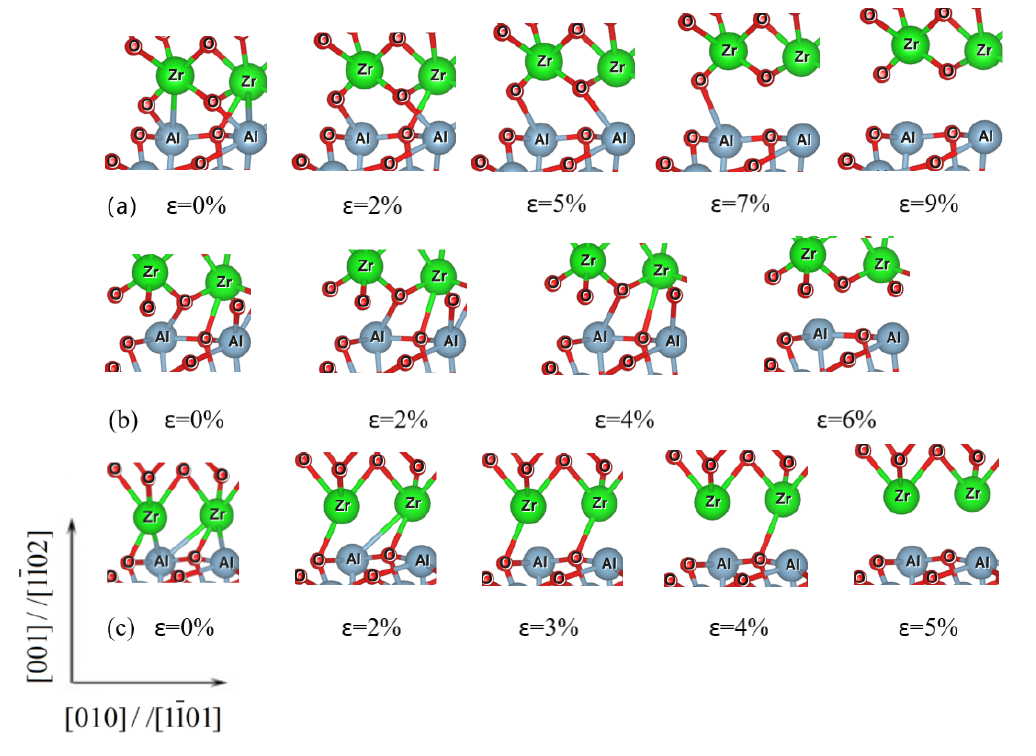
Figure 4. Pictorial representation showing the evolution of the interfacial atomic bonds for the c-ZrO 2 /α -Al 2 O 3 interfaces under the tension loading. ( a ) O-terminated, ( b ) 2O-terminated, and ( c ) Zr-terminated.